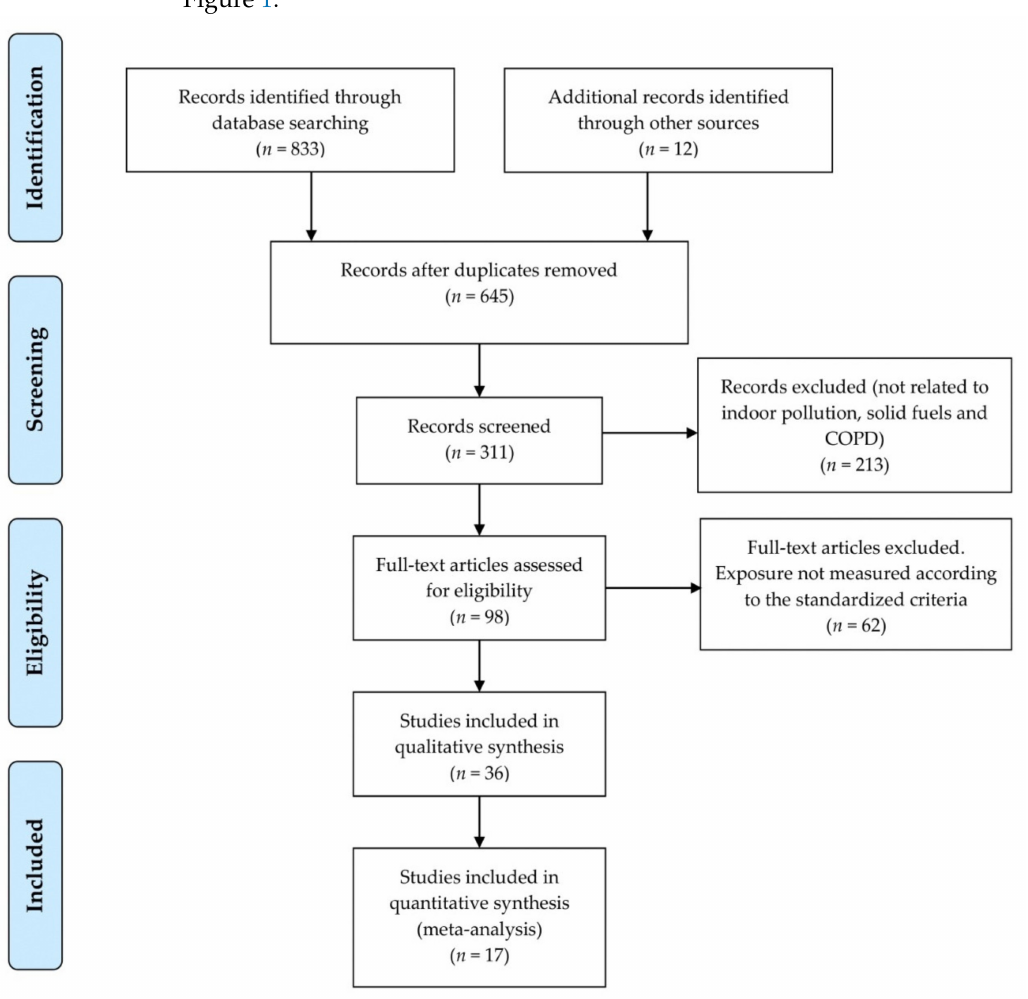
Figure 1. The above flow chart describes the methodology and flow for searching strategy of studies. Preferred Reporting Items for Systematic Reviews and Meta-Analyses (PRISMA) study selection flow